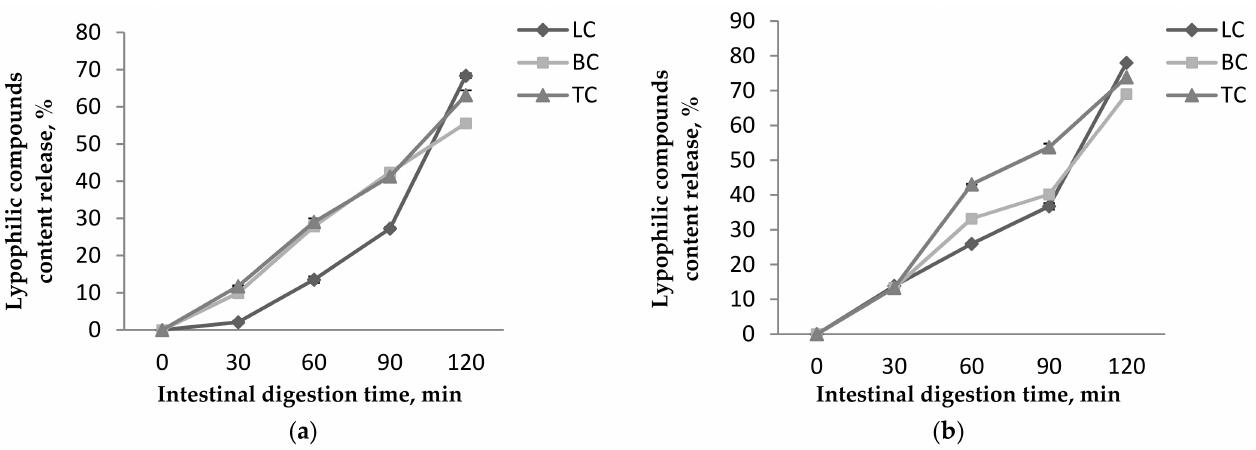
Figure 5. Lypophilic compounds content release from P1 ( a ) and P2 ( b ) during the in vitro gastric digestion.